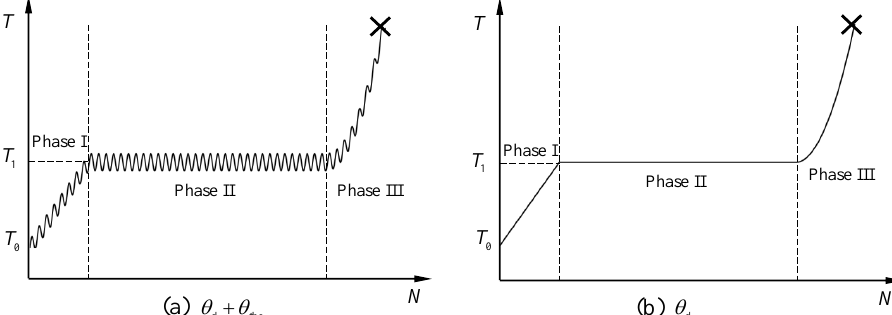
Figure 5. Schematic of three thermodynamic phases in a fatigue process: ( a ) temperature varia- tion induced by both the thermoelastic coupling effect and the energy dissipation effect, and ( b ) temperature variation induced by the energy dissipation